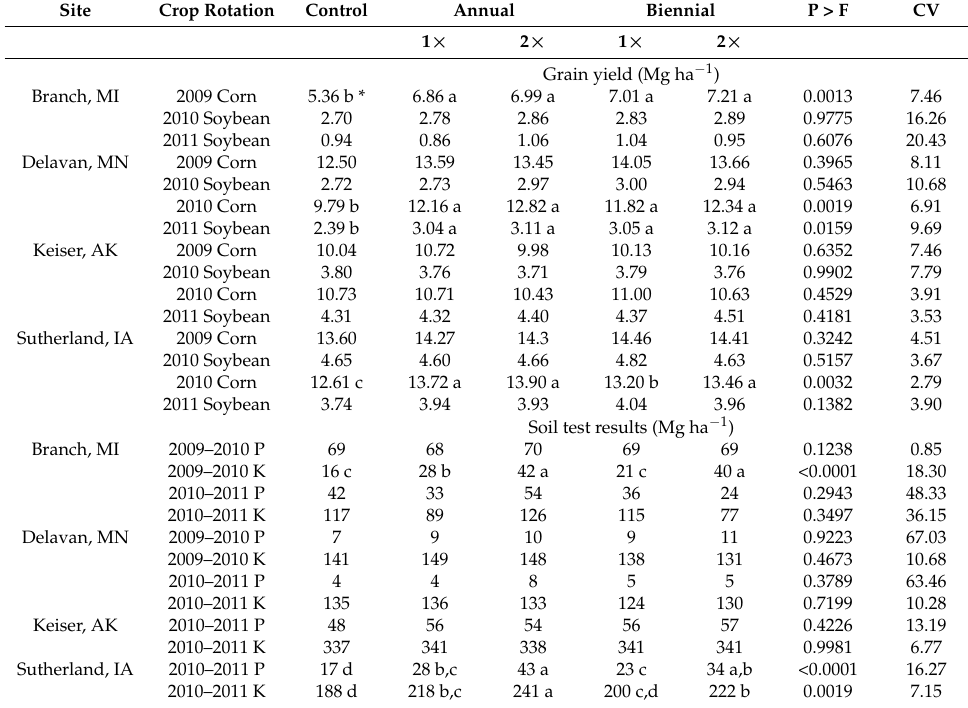
Table 6. Corn and soybean grain yield and soil test results affected by fertilizer treatments at sites with optimal P and above optimal K.